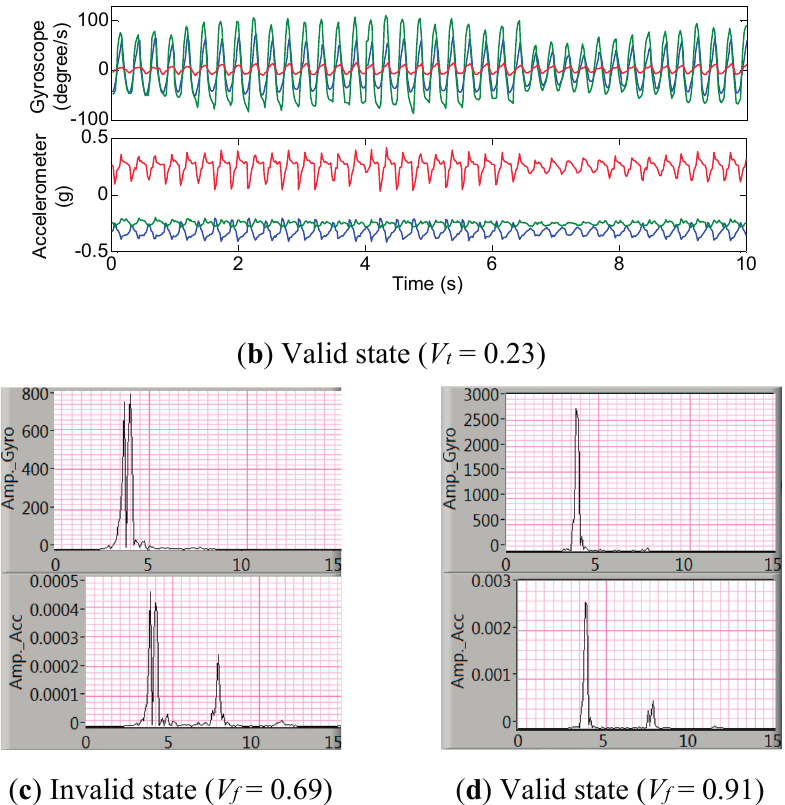
Figure 6. Tremor state for a patient with parkinsonian tremor (UPDRS score D = 1): ( a , b ): The three-axis angular velocity and three-axis acceleration waveforms of rest tremor; ( c , d ): The three-axis combined power spectra of angular velocity signals ( bottom chart ) and acceleration signals ( upper chart